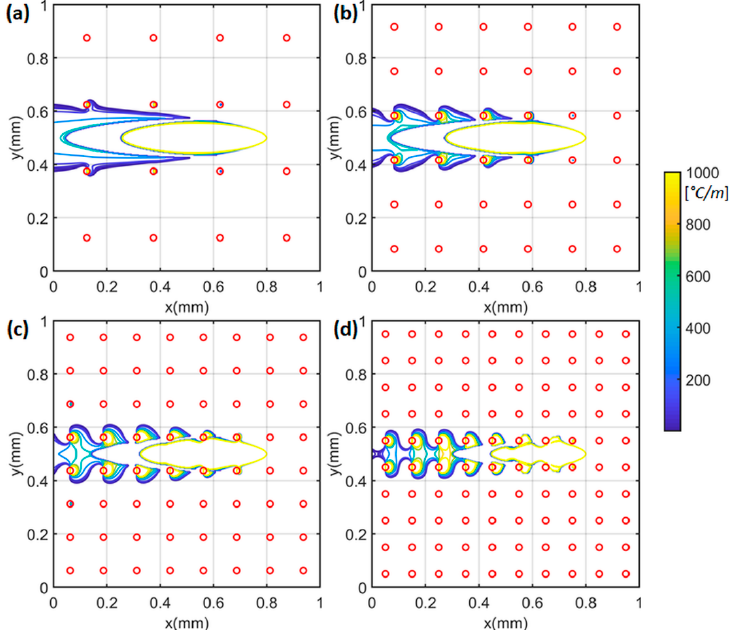
Figure 3. Calculated temperature gradient with ( a ) 4 × 4 = 16 heat sinks, ( b ) 6 × 6 = 36 heat sinks, ( c ) 8 × 8 = 64 heat sinks, and ( d ) 10 × 10 = 100 heat sinks. The moving laser is located at x = 0.8 mm, y = 0.5 mm. Red circles represent the centers of heat sinks.